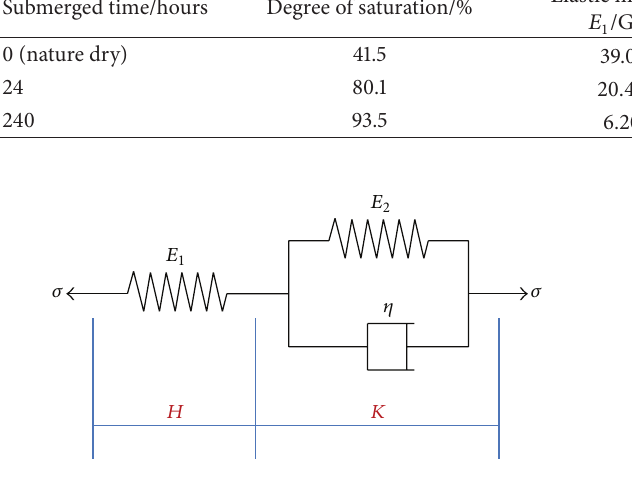
Figure 6: The three-parameter generalized Kelvin